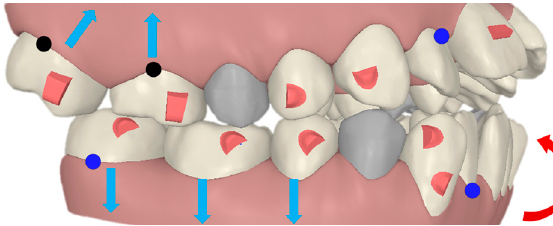
Figure 14. Counter-clockwise rotation of the mandible.